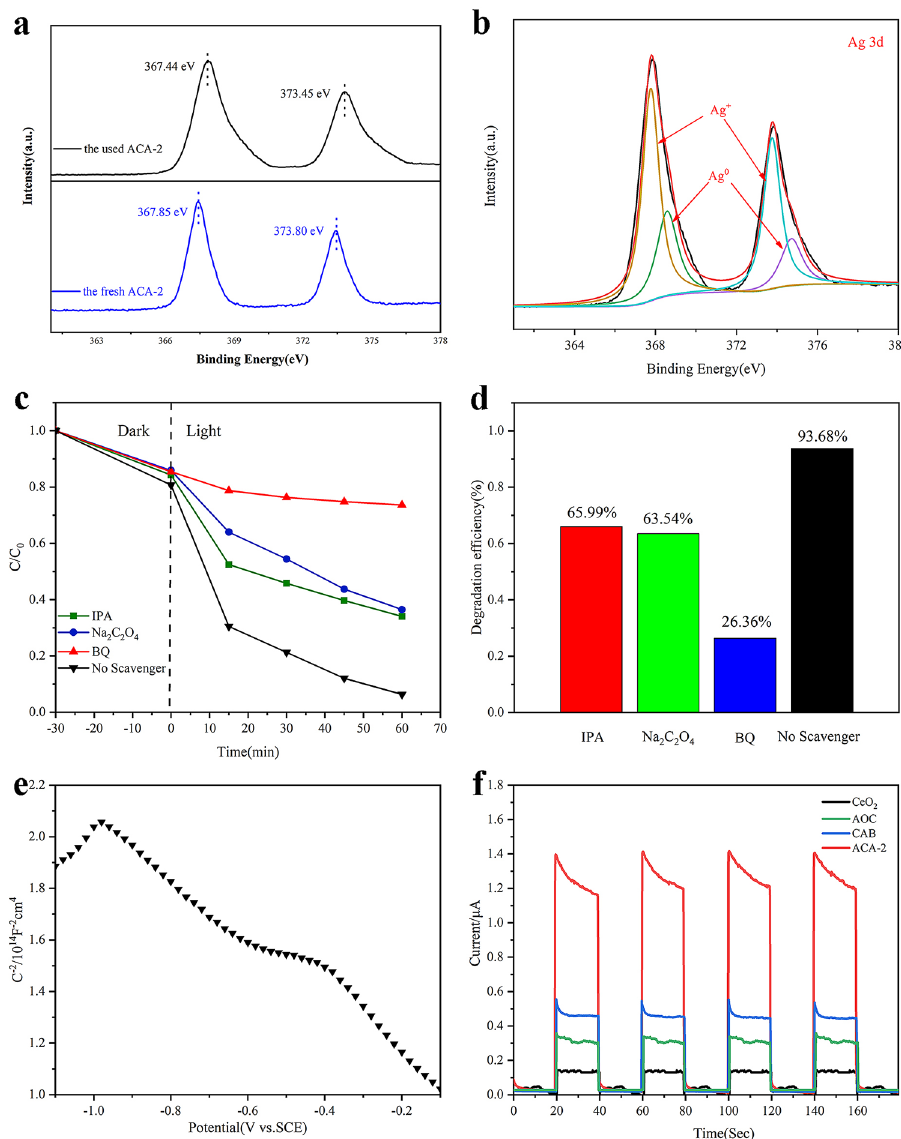
Figure 6. ( a ) Ag XPS spectrum of the ACA-2 before and after photoreaction; ( b ) Ag XPS spectrum of ACA-2 after photoreaction; ( c ) effects of reactive species scavengers on the RhB degradation performance of ACA-2 and ( d ) degradation rate; ( e ) Mott–Schottky curve of ACA-2; ( f ) Transient photocurrent response for CeO 2 , AOC, CAB and ACA-2 composites under visible light